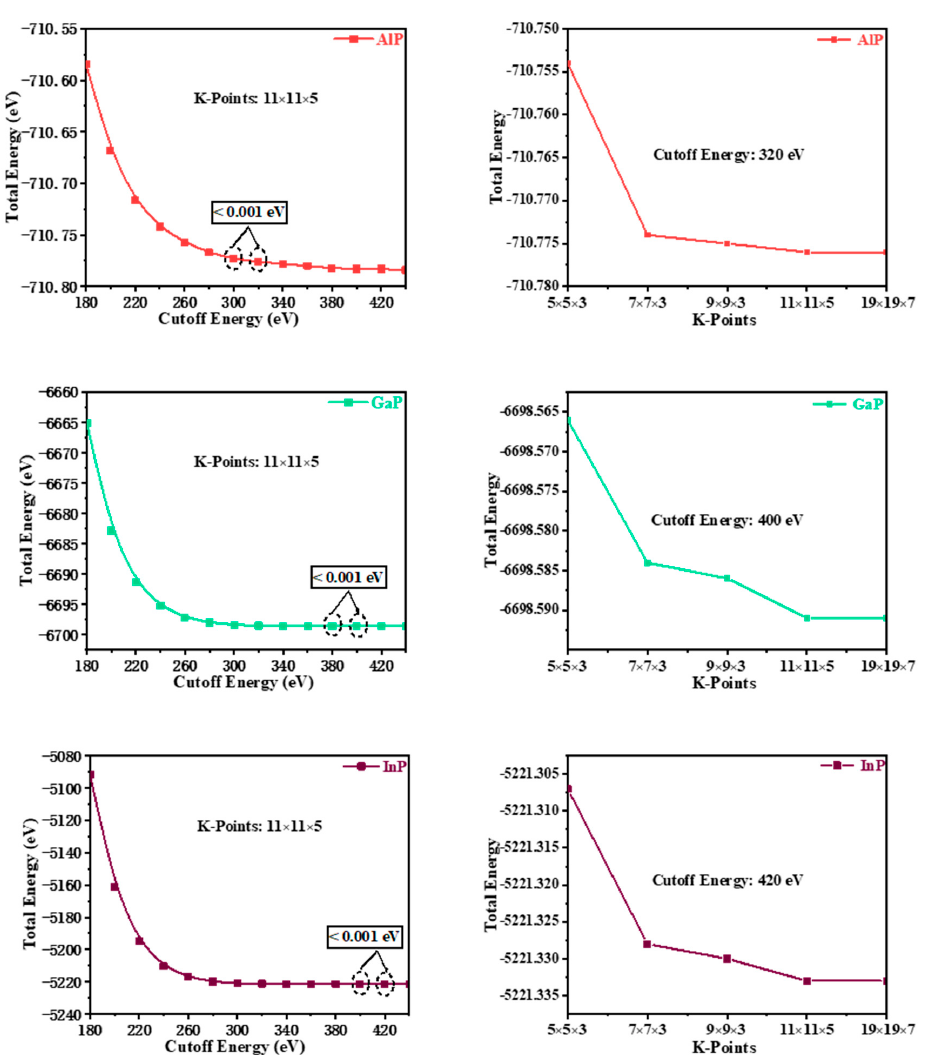
Figure 1. The convergence analysis of cut-off energy and the k-point grid allocation in the Brillouin zone.